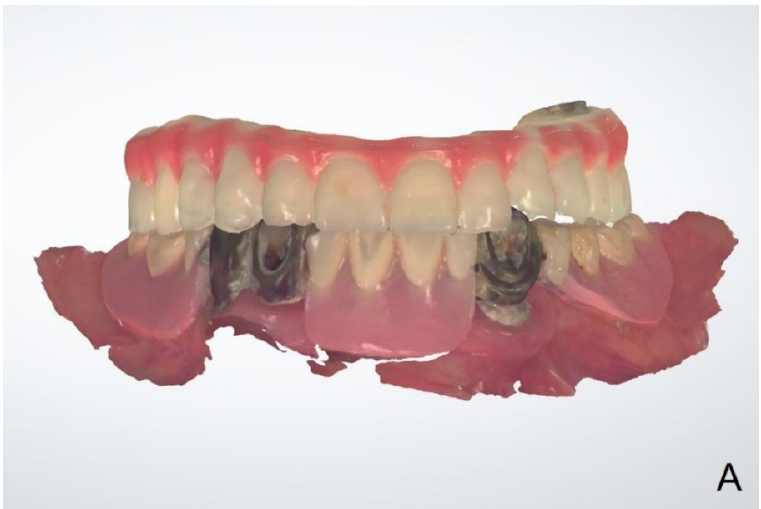
Figure 6. Interim prosthesis after sectioning the denture flange part.